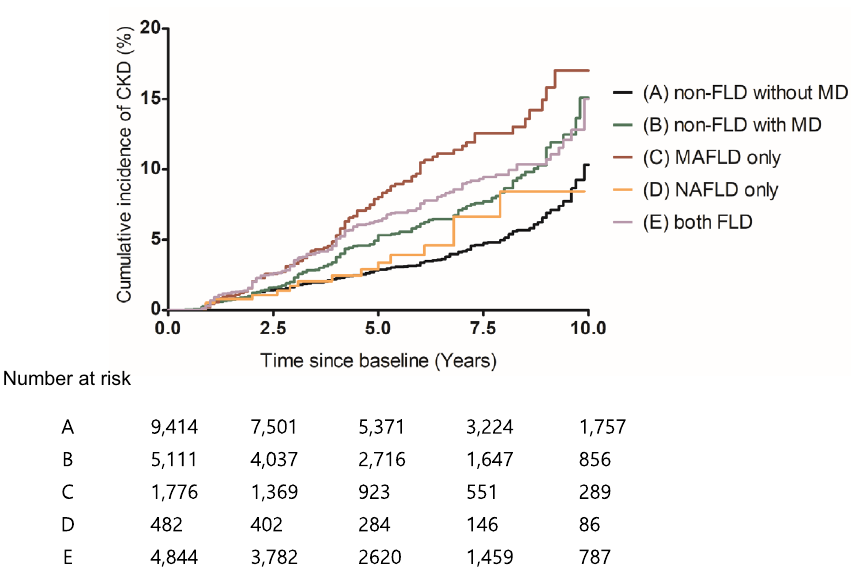
Figure 2. Cumulative CKD incidence over 10 years by Kaplan–Meier methods according to presence and combination of MAFLD and NAFLD-non-FLD with or without MD, MAFLD only, NAFLD only, or both FLD.